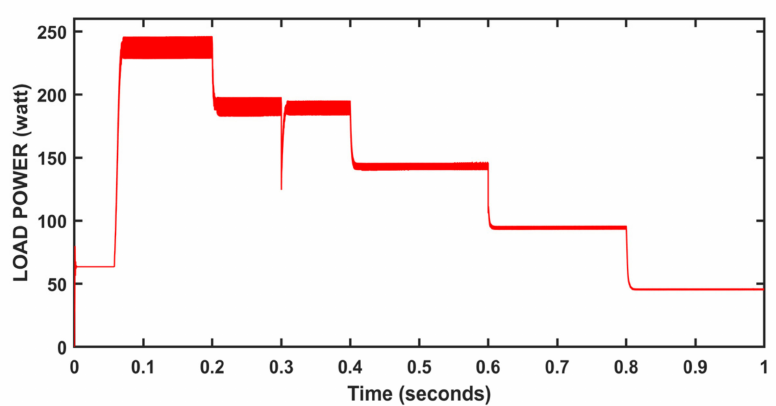
Figure 35. Performance at variable loads and varying irradiances.